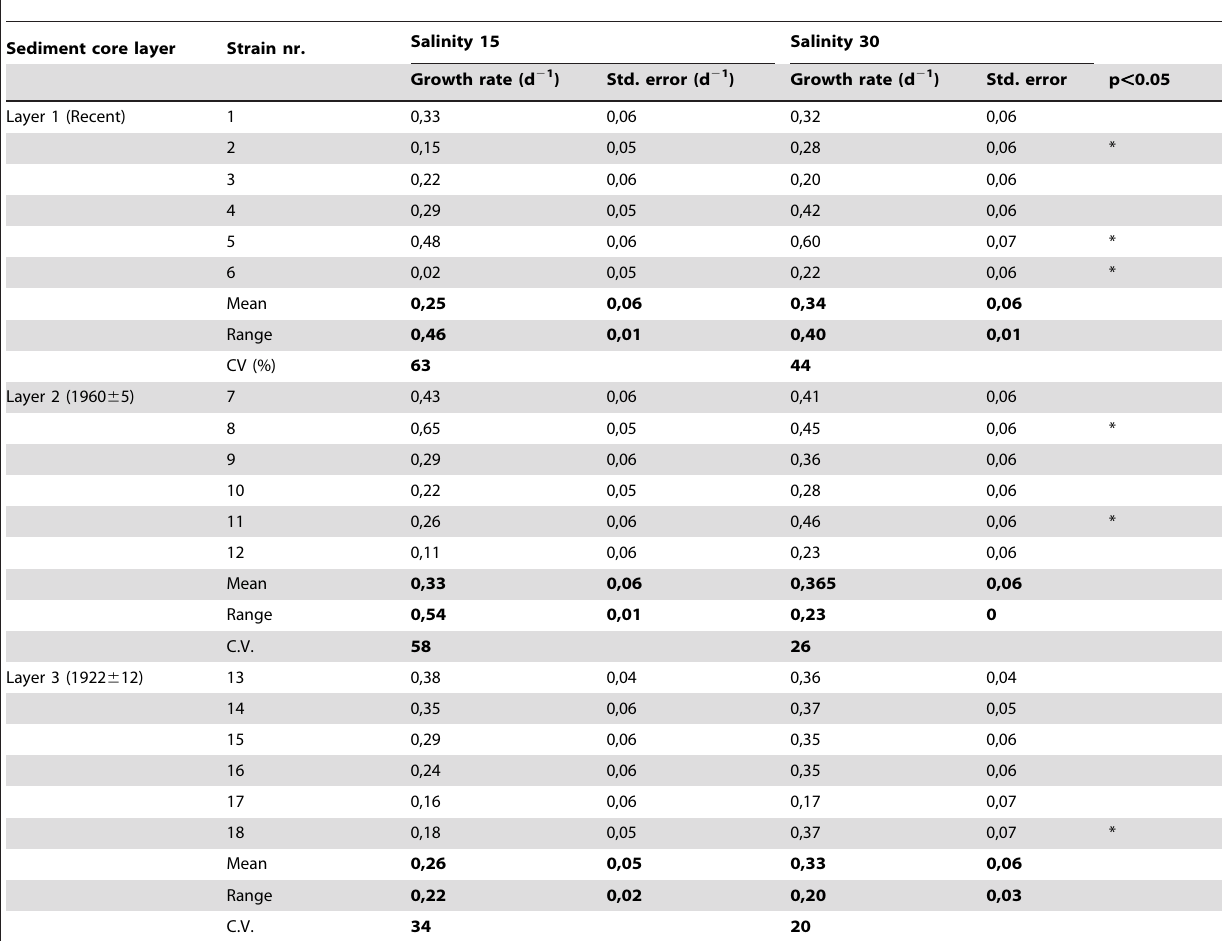
Table 1. Observed growth rates for the 18 strains tested at salinity 15 and 30 with standard error.